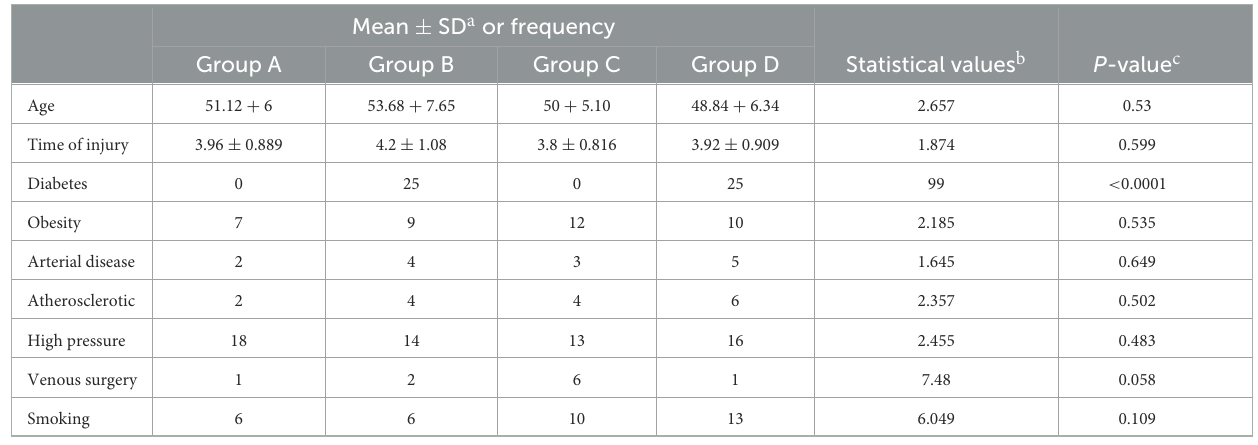
TABLE 1 Patients’ demographics, including age, for the three tested groups at baseline.